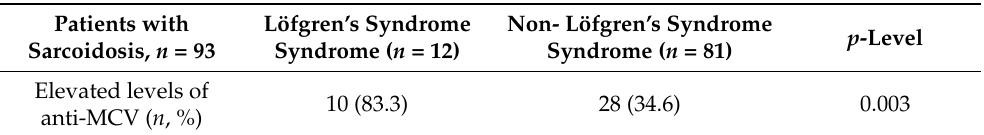
Table 4. Antibodies to mutated citrullinated vimentin (anti-MCV) in patients with acute sarcoidosis (Löfgren’s syndrome).